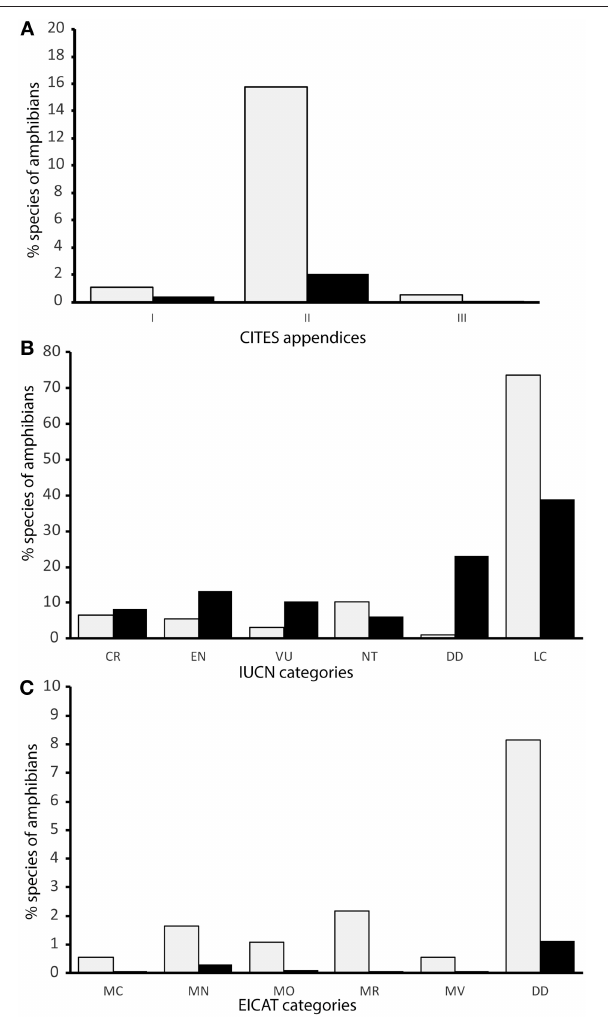
FIGURE 2 | Percentages of amphibian species identified in captive YouTube videos (gray bars) with (A) listed in CITES appendices, (B) IUCN Red List status, and (C) EICAT scores, compared to all amphibians (black bars). Note that in (A) categories “Extinct” (EX) and “Extinct in the wild” (EW) are not included, and in (B) the group “Not Alien” (NA) is not included, but represented 85.9% of species identified in YouTube videos ( n = 184) and 98.3% of all amphibians. Similarly, in (C) , species not on a CITES appendix are not included and represented 82.6% of species identified in YouTube videos ( n = 184) and 97.5% of all